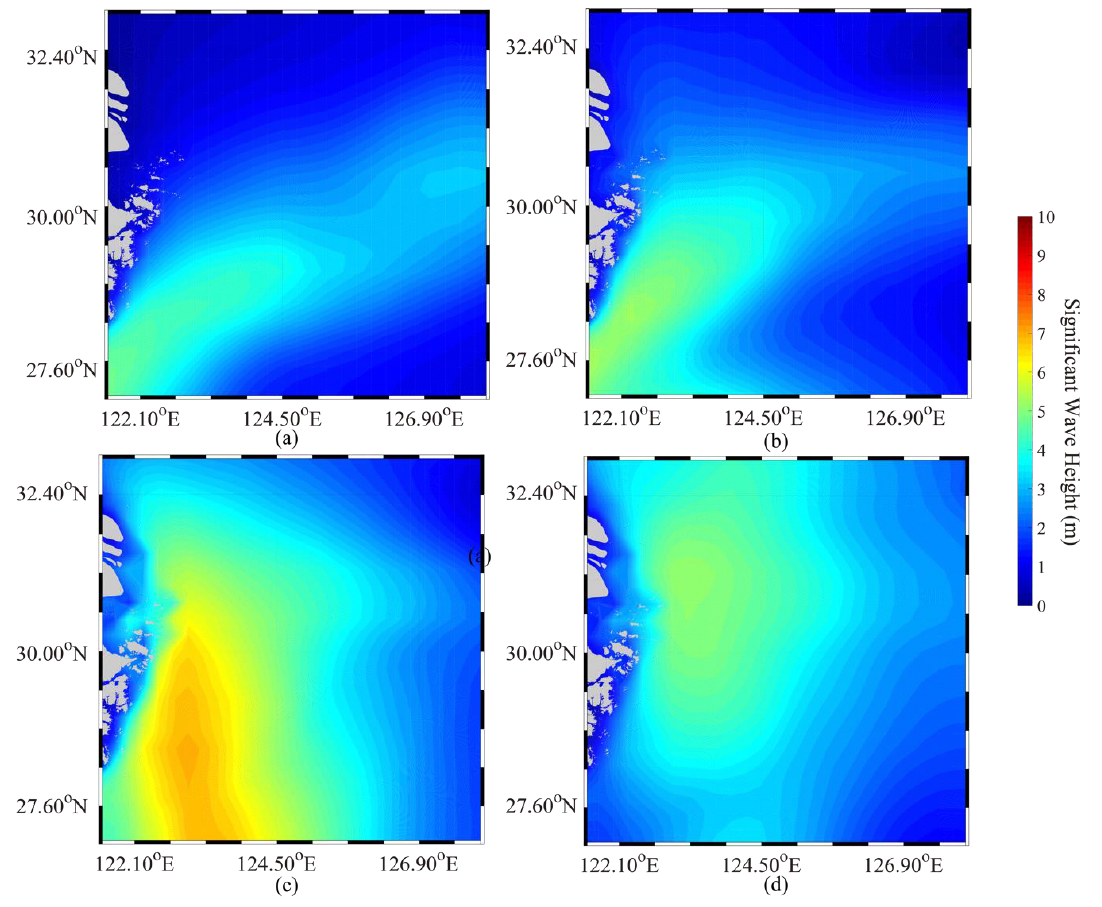
Figure 15. The average SWH maps simulated by the SWAN model when Typhoon Fung-wong passed the Zhoushan Islands on ( a ) 20 September 2014, ( b ) 21 September 2014, ( c ) 23 September 2014, and ( d ) 23 September